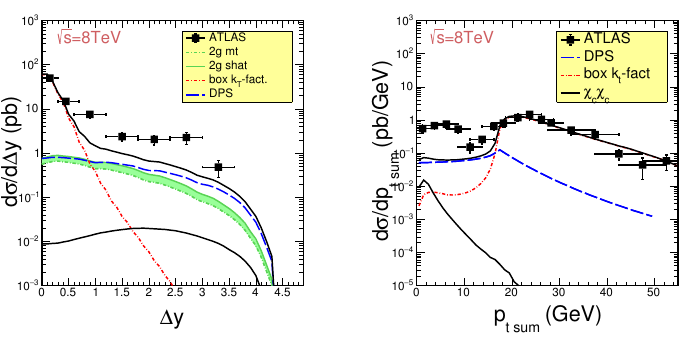
Figure 8. Distributions in rapidity distance between J /ψ ’s (left) and pair transverse momentum (right). The cuts on J /ψ ’s are: | y ( J /ψ ) | < 2 . 1 , p T ( J /ψ ) > 8 . 5GeV. In addition cuts on the decay muons